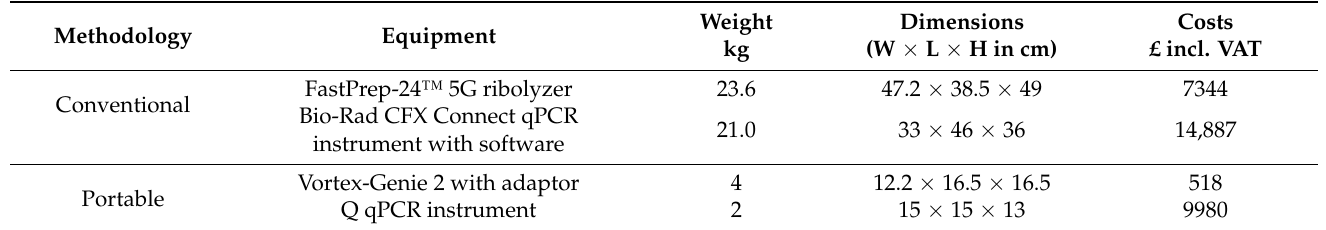
Table 1. Specifications and costs of conventional and portable equipment items for cell lysis and